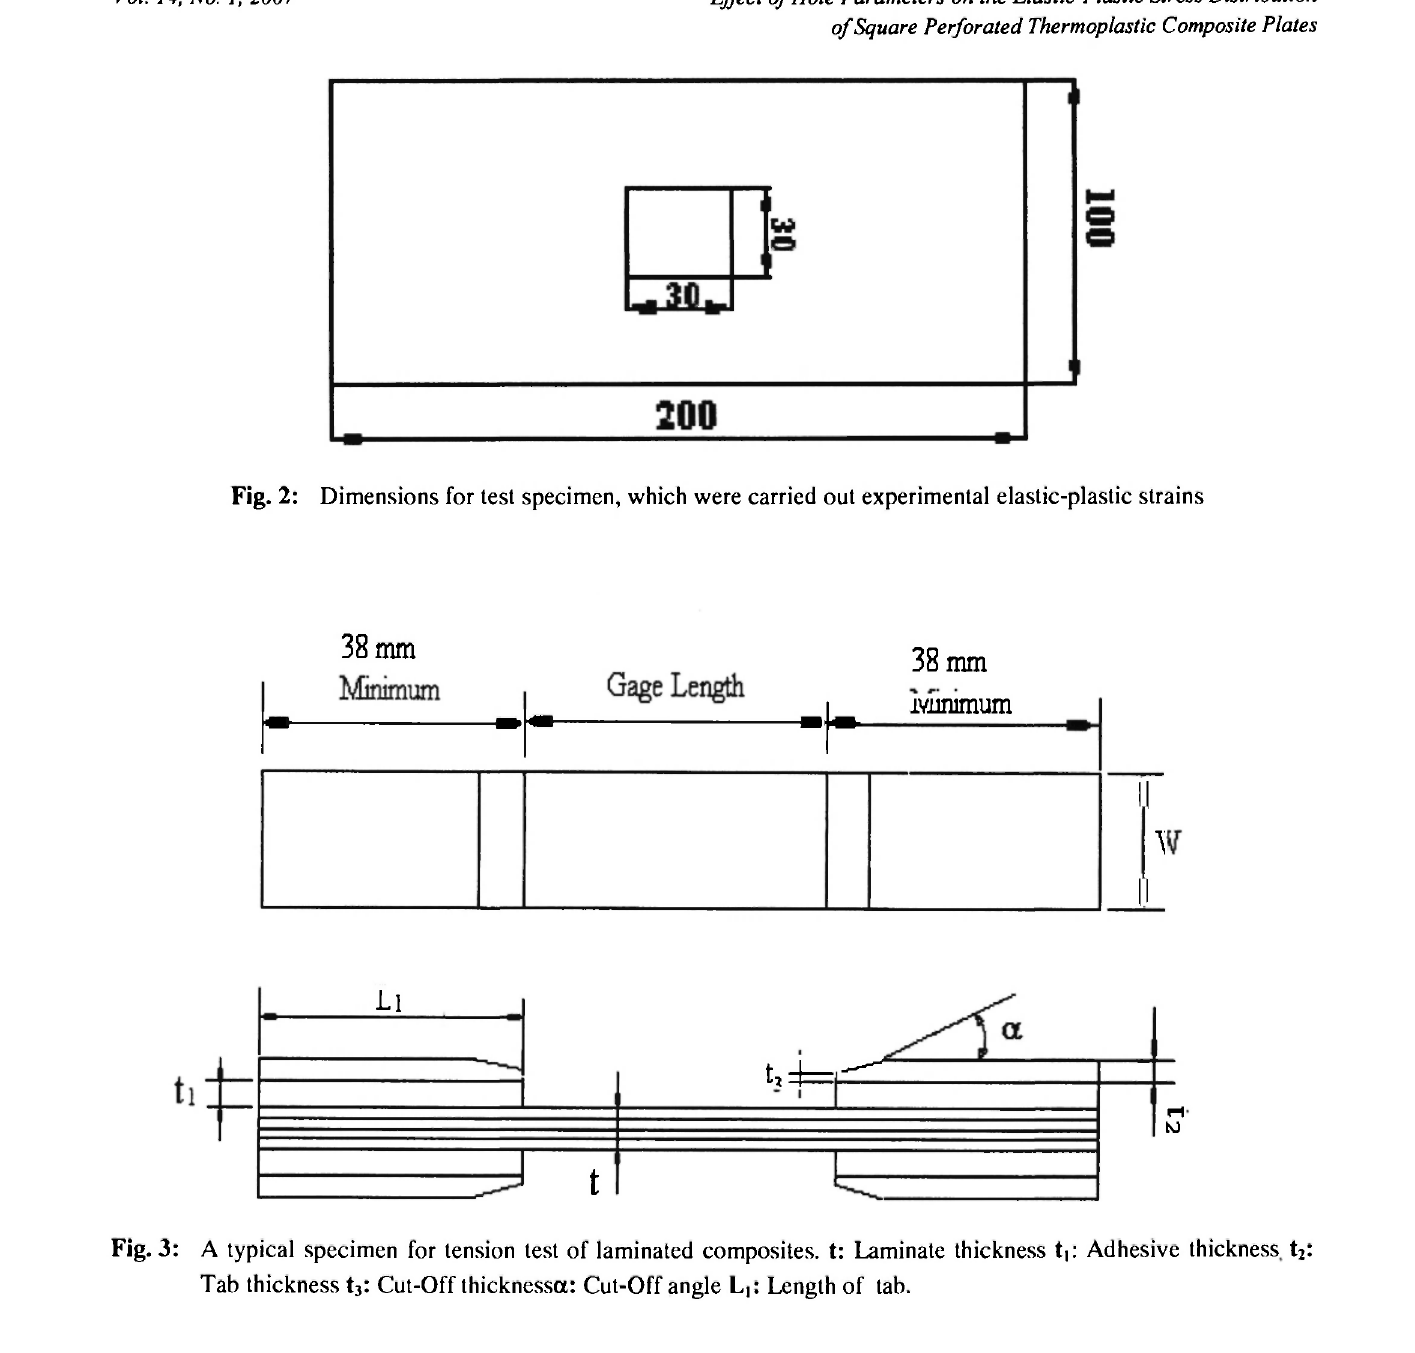
with Instron 4301 universal testing machine. Ten data were acquired per second. The plasticity modulus was calculated from stress-strain curve (Fig.4). The results are shown in Table 3. b)